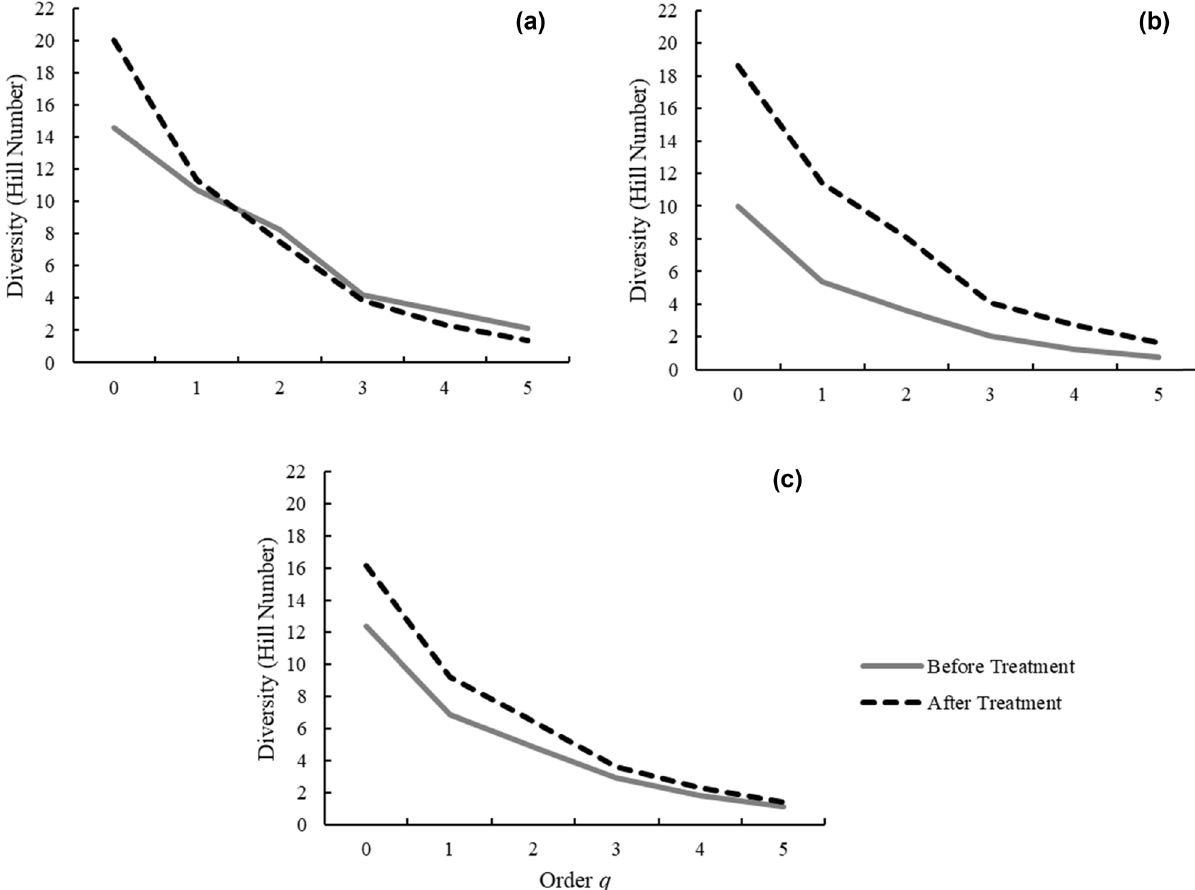
Figure 3: Diversity pro fi le ( Hill numbers ) , at the horticultural fi eld, in the two studied periods, for the di ff erent treatments: ( a ) chicken treatment, ( b ) mechanical treatment, and ( c ) thermal